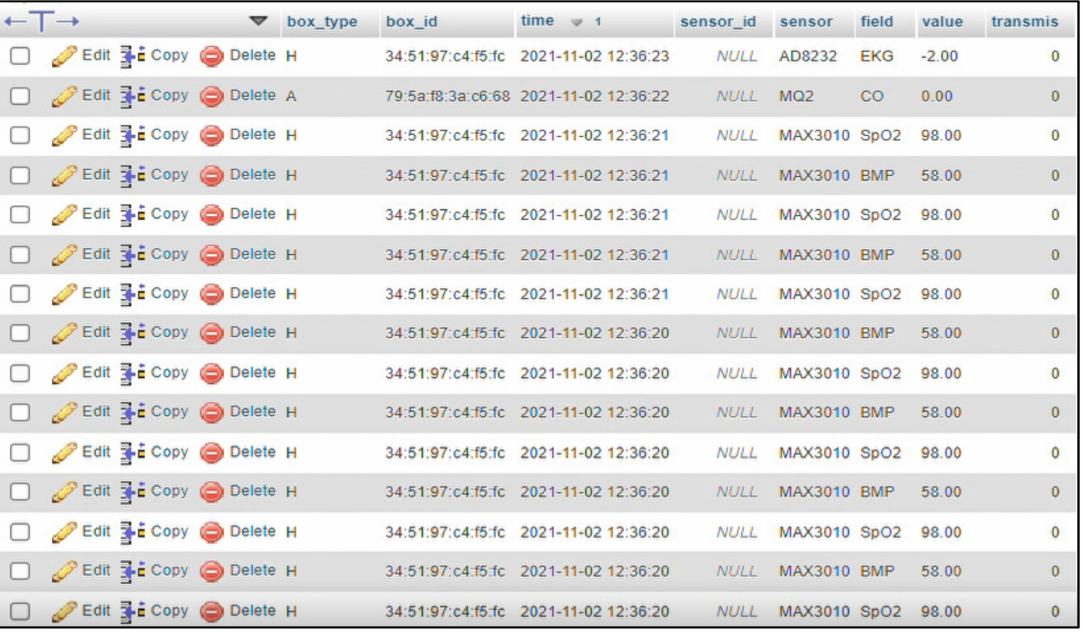
Figure 12. Illustration of the representation in the RO-SmartAgeing database of the measurements performed with a Withings